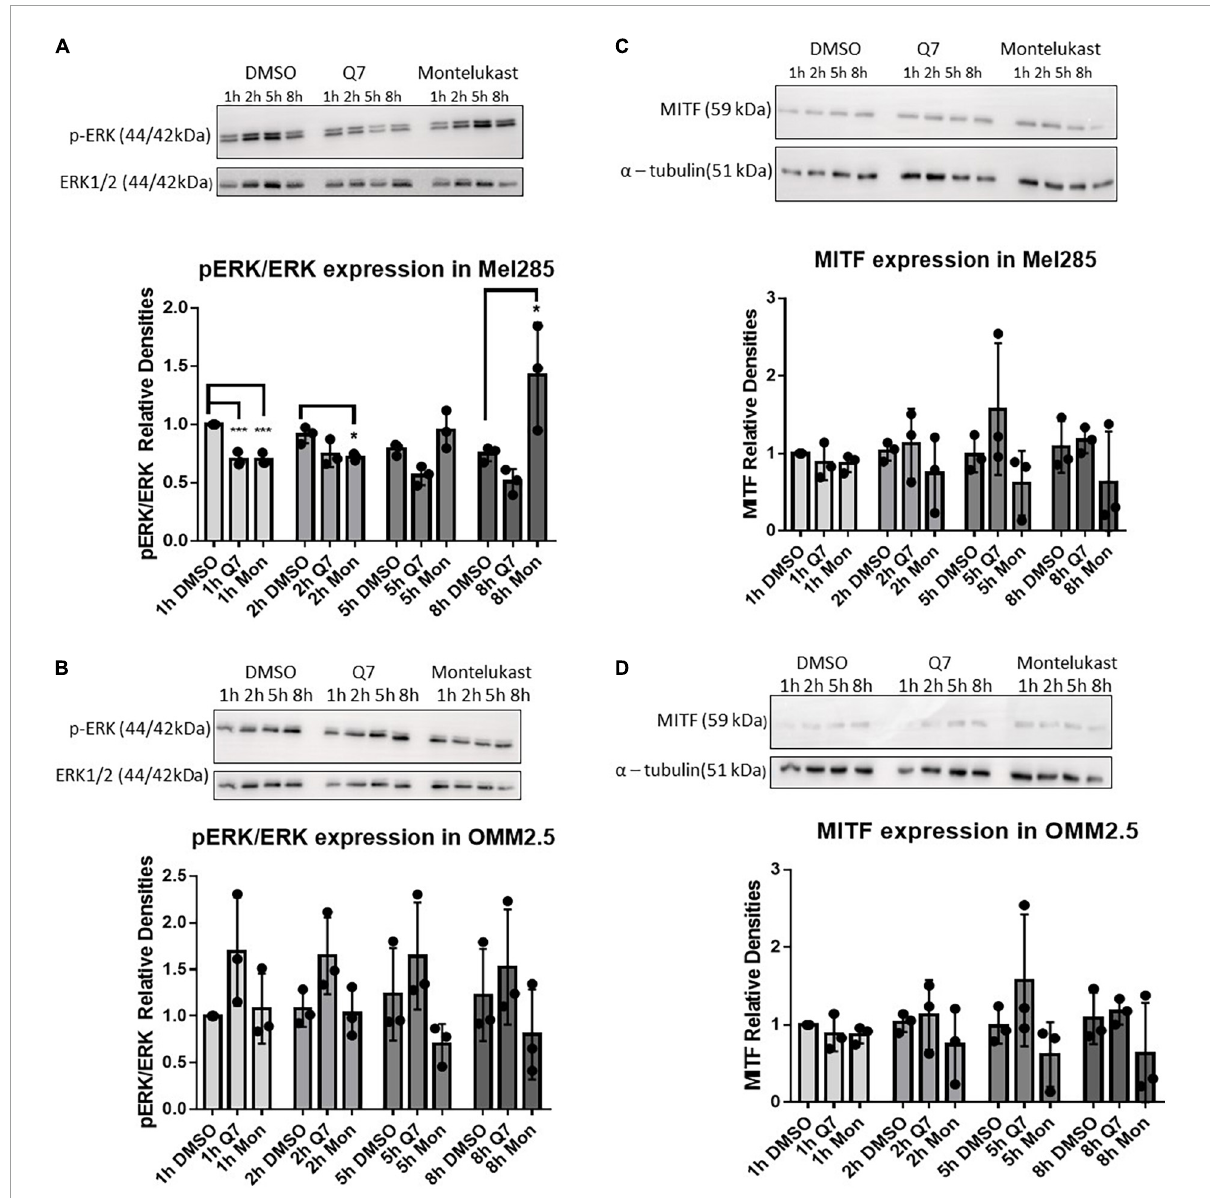
FIGURE4 Treatment with CysLT 1 antagonists alters expression of phospho-ERK in Mel285 cells. (A–D) Representative western blots and densitometry analysis. (A) Relative phospho-ERK expression was significantly reduced in Mel285 cells treated with 1,4-dihydroxy quininib or montelukast for 1 h and montelukast for 2 h. Relative phospho-ERK expression was significantly increased in Mel285 cells treated with montelukast for 8 h. (B) Relative phospho-ERK expression was not significantly altered by treatment with 1,4-dihydroxy quininib or montelukast in OMM2.5 cells at any time point analyzed. (C,D) MITF expression normalized to α -tubulin shows treatment with 1,4-dihydroxy quininib or montelukast does not significantly alter a 59 kDa isoform of MITF expression at any time point analyzed in Mel285 cells or OMM2.5 cells. Immunoblotting was conducted three separate times using protein lysates from three individual experiments. Differences in protein expression were assessed between drug treatments conducted for the same length of time. Statistical analysis was performed by ANOVA with Dunnett’s post-hoc multiple comparison test. Error bars are mean ± S.E. * p < 0.05; *** p <